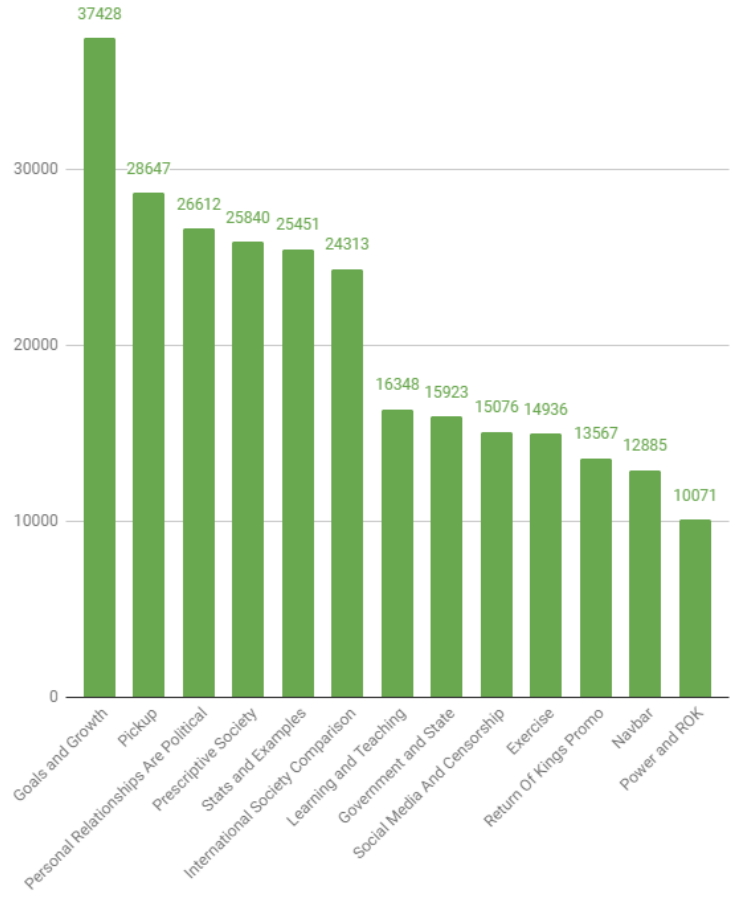
Figure 2. Frequency chart of how often topics were identified within the corpus.